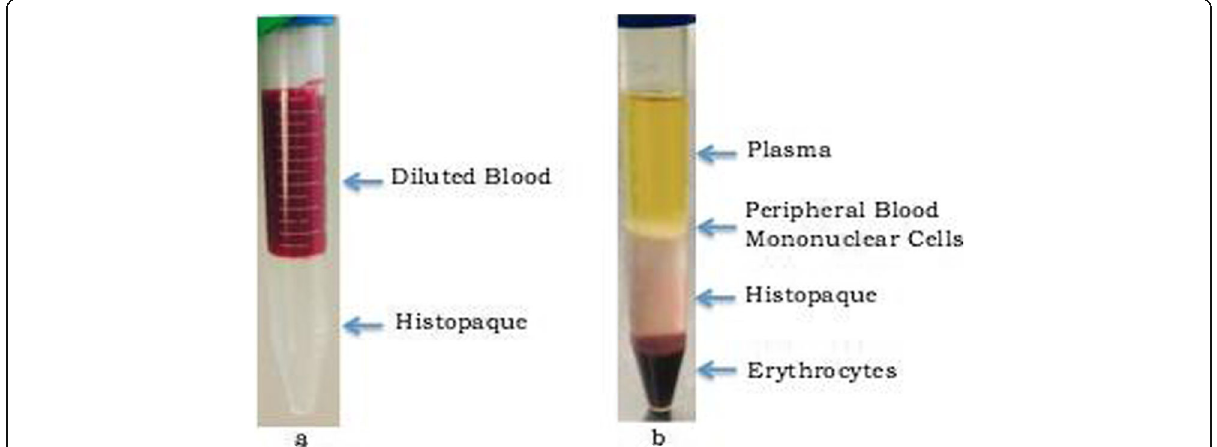
Fig. 7 Blood sample collected for isolation of lymphocytes. b Different layers separated after